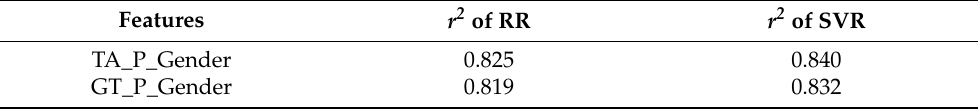
Table 6. The regression coefficient ( r 2 ) for the RR and SVR models when adding combined features, TA_P_Gender and GT_P_Gender,